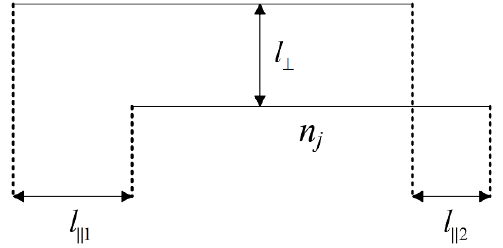
Figure 5. Vertical distance, parallel distance